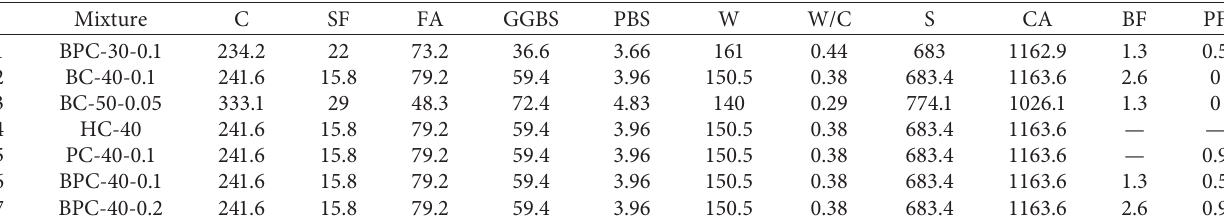
Table 4: Mix proportions of BPFRC (kg/m 3